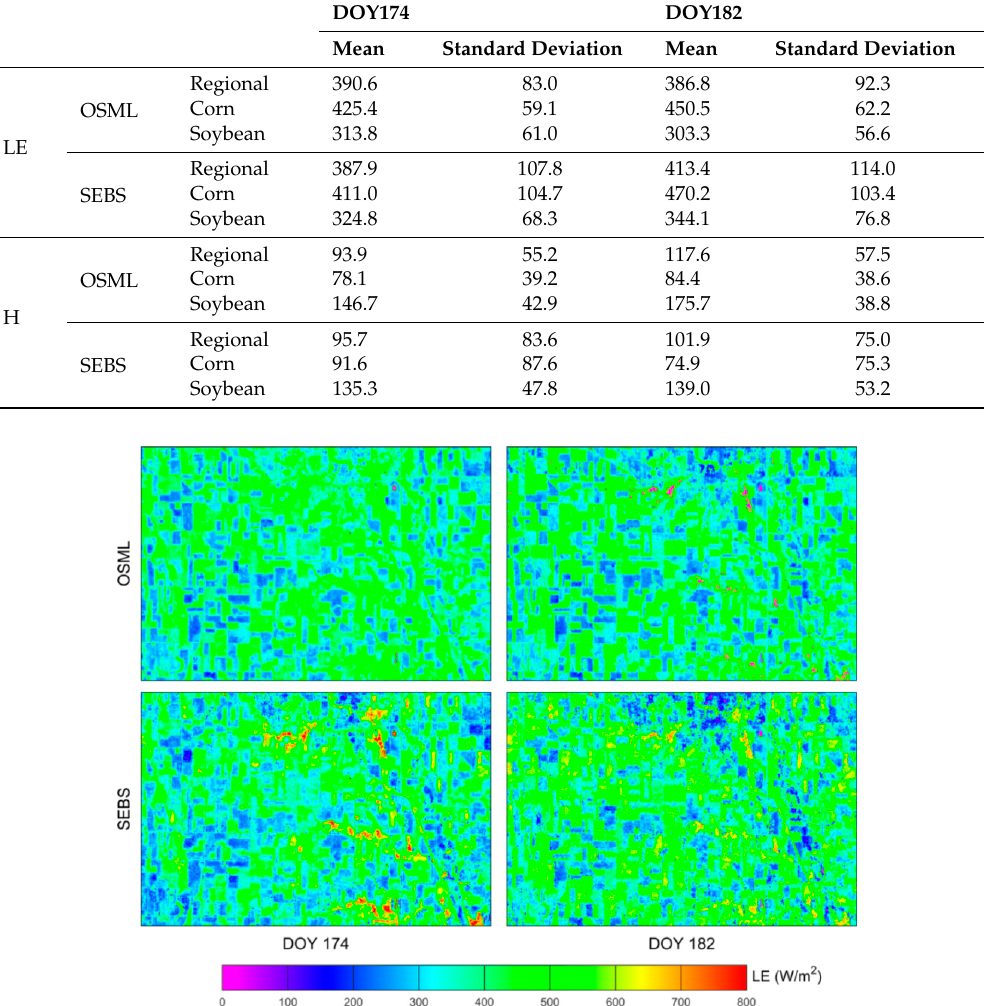
Figure 6. The spatial distribution of LE estimated using OSML and SEBS from Landsat-based retrievals on DOY 174 and 182.